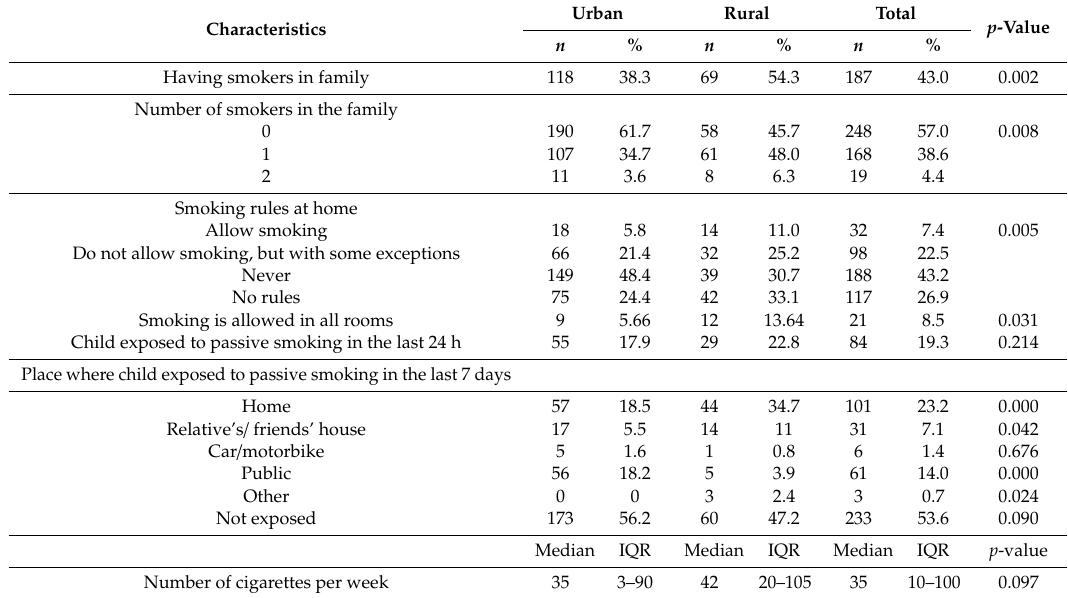
Table 2. Passive smoking exposure among children attending pediatric care services.